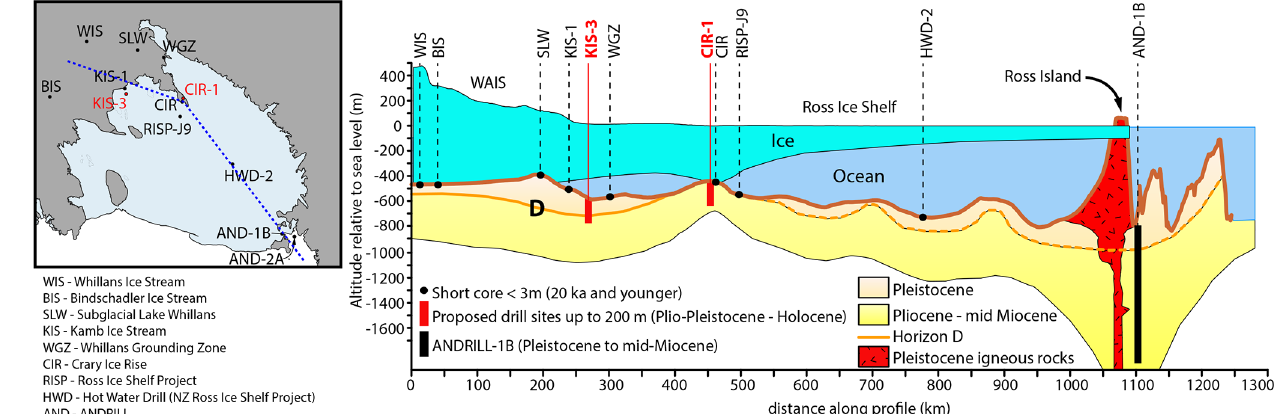
Figure 4. Regional stratigraphic correlation schematic. Dashed blue line is the location of the cross section. D is Horizon D identified at the KIS-3 site.